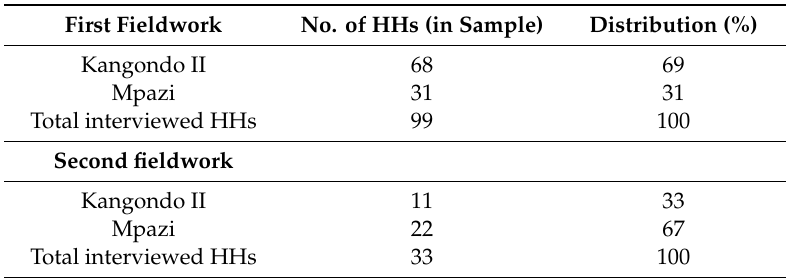
Table 2. Respondents in interviews with head of